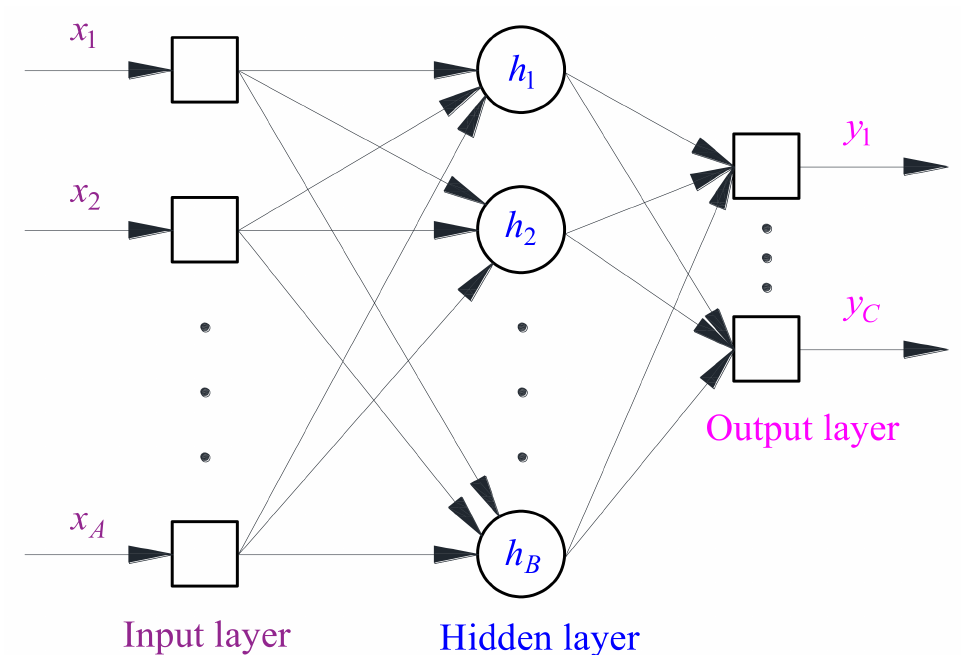
Figure 7. Topological graph of the BP neural network [16]. When the neurons in the input layer are assigned a data set regarding the w , σ 3 , or σ d , the neurons in the hidden and output layer(s) will generate values by following a transfer function, and the yielded values of the neuron in the output layer are the evaluated values of β . In the self-training of a BP neural network, the yielded values in the output layer (i.e., the evaluated values of β ) generally exhibit deviations in comparison to the theoretical values or expectations. In this study, the expectations of β are 1.0, 2.0, and 3.0 regarding the stable, critical, and failure specimens, respectively. By inputting a series of data sets that correspond to different test conditions of w , σ 3 , or σ d , the computation of the BP neural network continues until the sum of deviations meets the required precision or the iteration number achieves the maximum. In this study, a sigmoid function was adopted for the transfer function, and the maximum of iterations is 2000. For more details regarding BP neural networks, one can refer to Rumelhart et al.